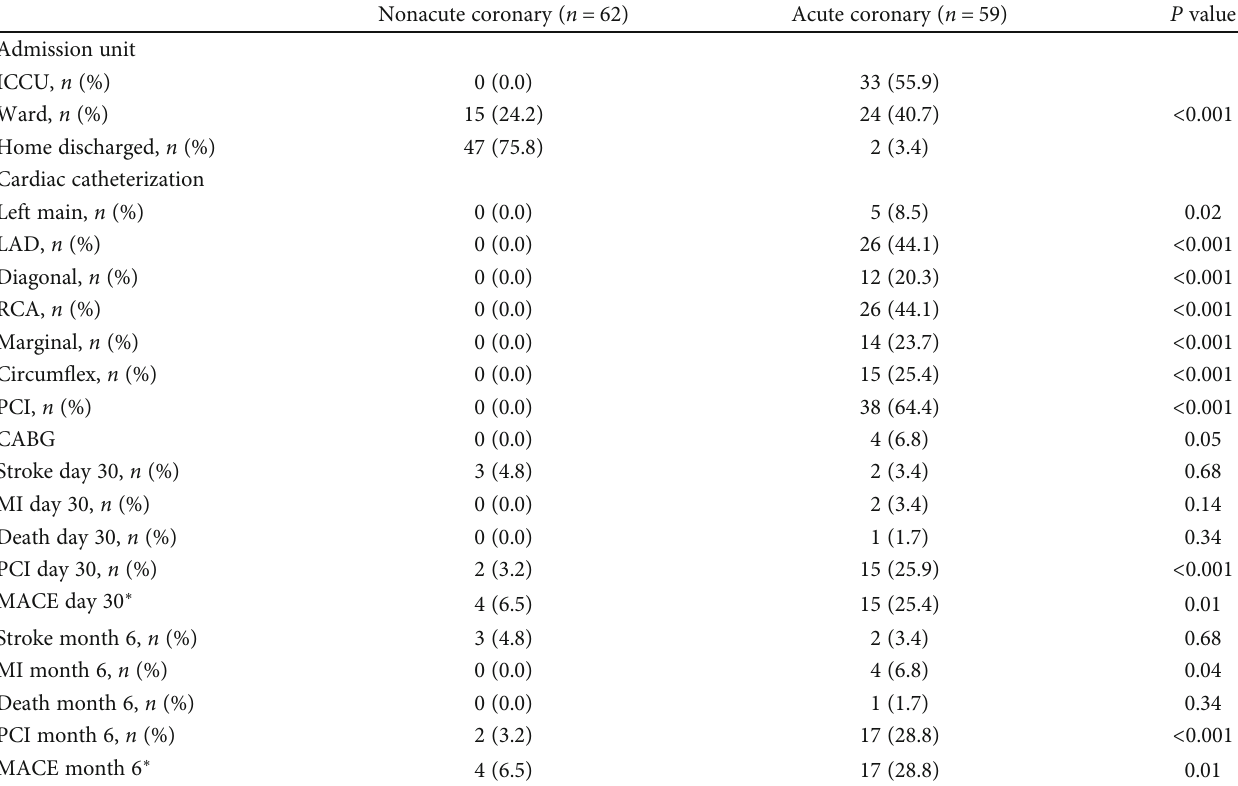
Table 2: Diagnostic measures and clinical